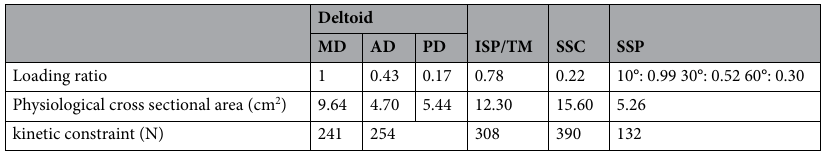
Table 1. Prior loading ratios and kinetic constraints of the controlled muscles. MD Middle deltoid, AD Anterior deltoid, PD Posterior deltoid, ISP/TM Infraspinatus/Teres minor, SSC Subscapularis, SSP